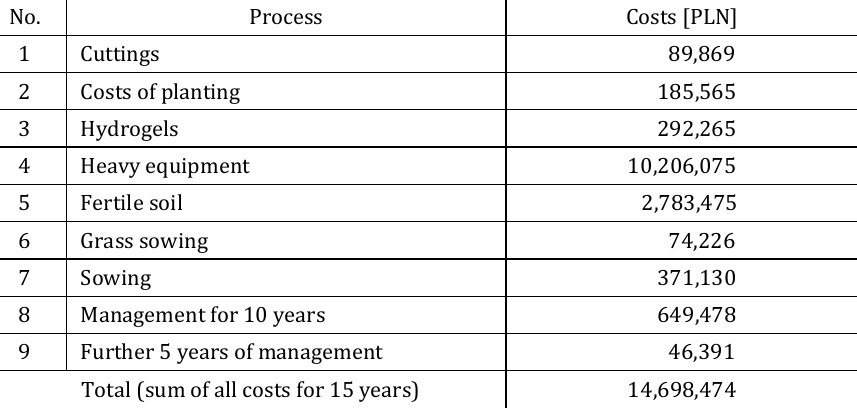
Fig. 4. Distribution of natural habitats after the reclamation process (source: WMS geoportal) Table 1. Costs of land reclamation into